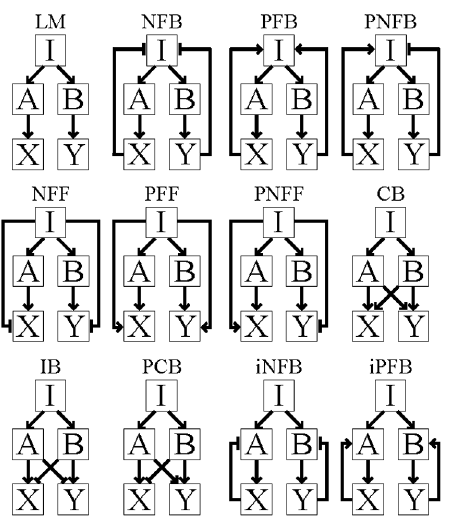
Figure 1. Motifs topologies overrepresented in mammalian signaling networks. In all of the motifs, ‘‘I’’ is the input source that activates signals across the networks; ‘‘A, B’’ are intermediate components; and ‘‘X, Y’’ are downstream effectors. LM: linear motif; NFB: negative feedback; PFB: positive feedback; PNFB: positive-negative feedback; NFF: negative feed-forward; PFF: positive feed-forward; PNFF: positive-negative feed-forward; CB: coherent bifan; IB: incoherent bifan; PCB: partially coherent bifan; iNFB: isolated negative feedback; iPFB: isolated positive feedback.